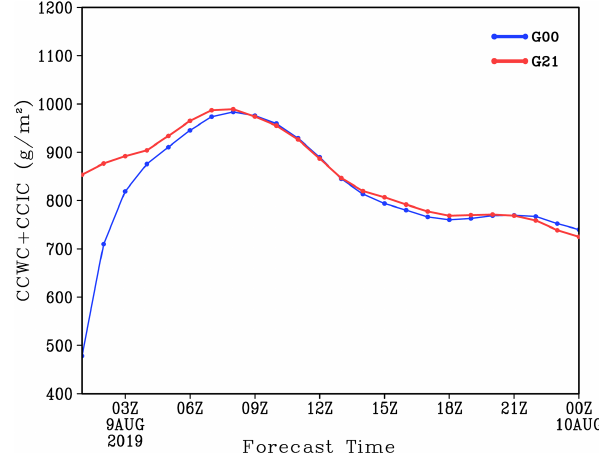
Figure 9. Time evolution of the sum of averaged column cloud wa- ter content (CCWC) and column cloud ice content (CCIC) at the typhoon Lekima region (22–34 ◦ N, 117–130 ◦ E) simulated by G00 and G21 experiment (values are given in gm − 2